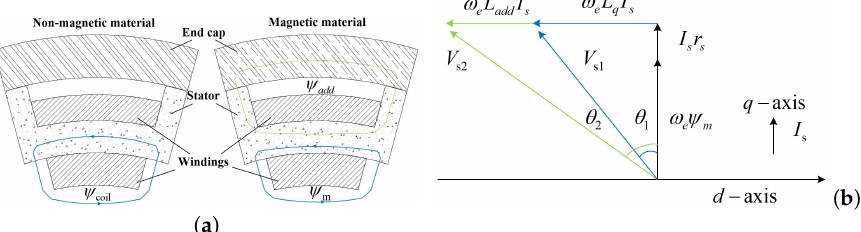
Figure 3. Schematic diagram of flux linkage of different materials and vector diagram of different materials. ( a ) Schematic diagram ( b ) vector